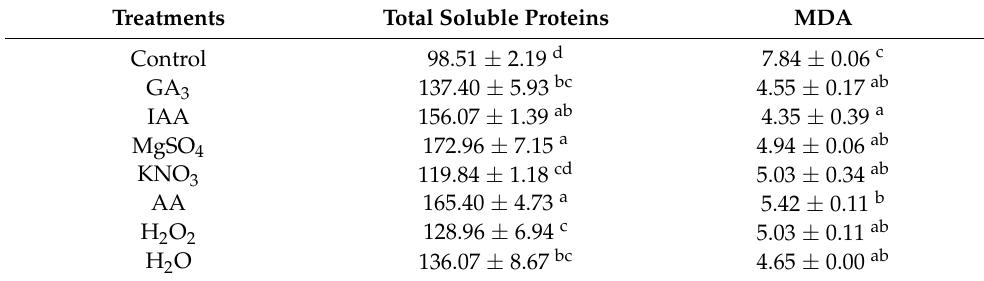
Table 2. Effect of different priming treatments on total soluble protein concentration (mg g − 1 FW) and malondialdehyde (MDA) content (nM g − 1 FW) in leaves of wheat seedlings.